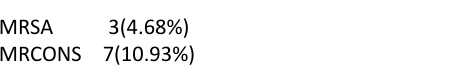
Table 2. Distribution of Bacterial Isolates Organisms Isolation